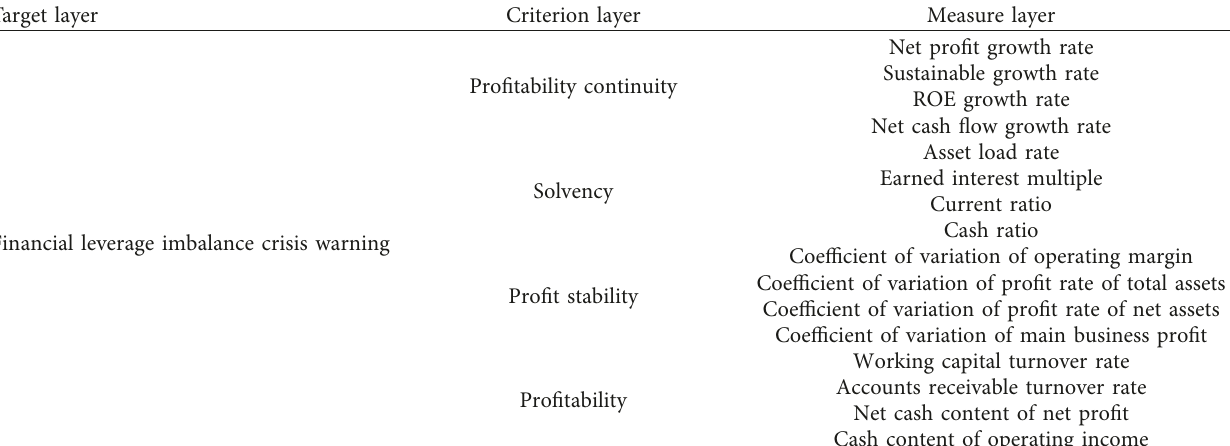
Table 2: Financial leverage imbalance crisis early warning evaluation index